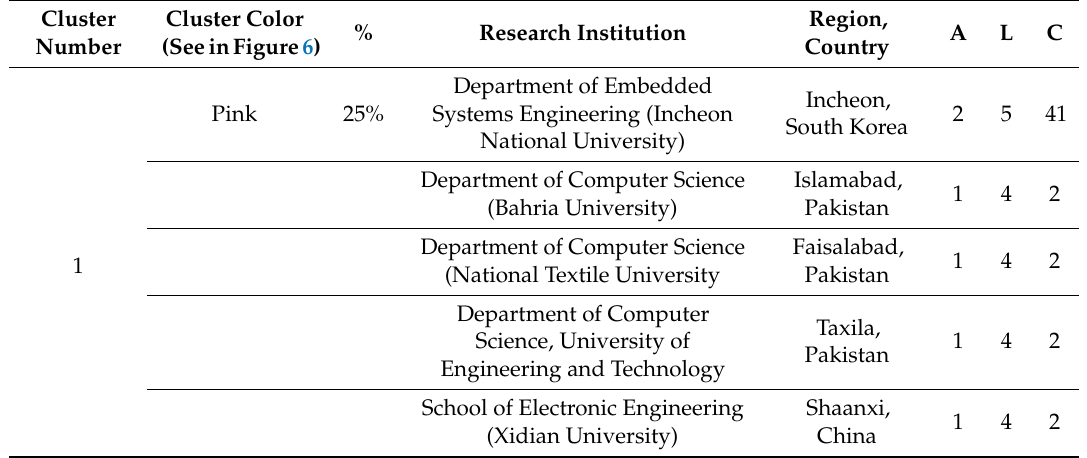
Table 14. Clusters of authors (2011–2019).